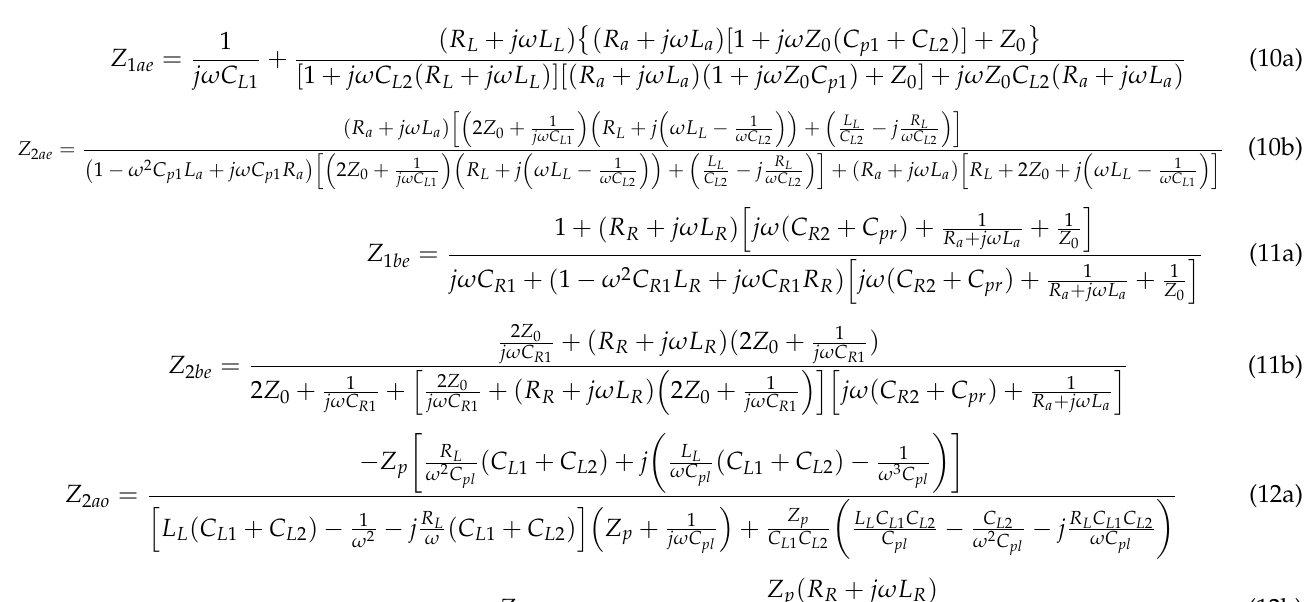
( b ) Port 1 and Port 3.